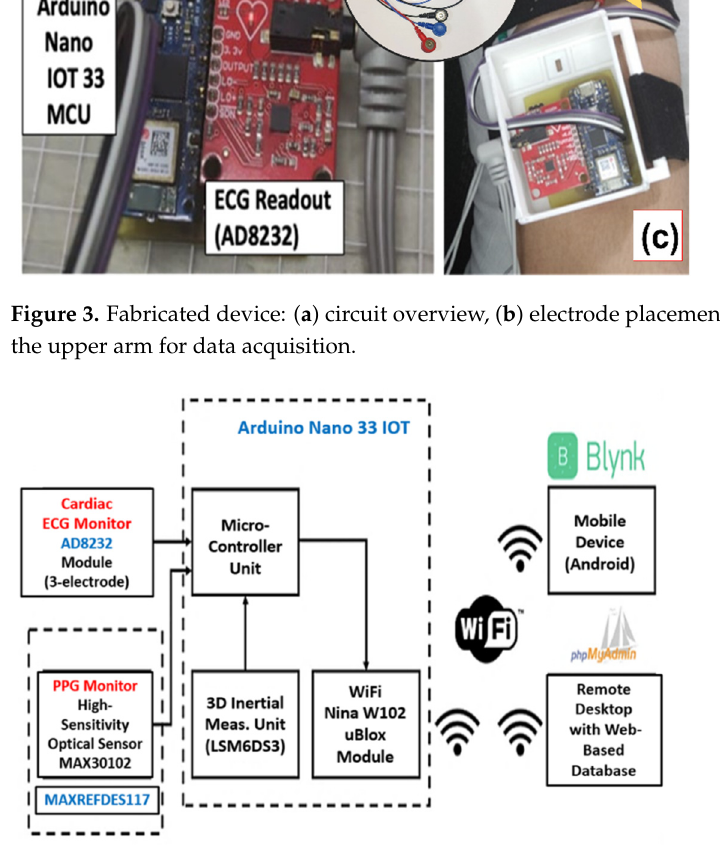
Figure 4. Wearable system block diagram showing the wireless interface via Wi-Fi to a mobile device and a desktop with a web ‐ based database.